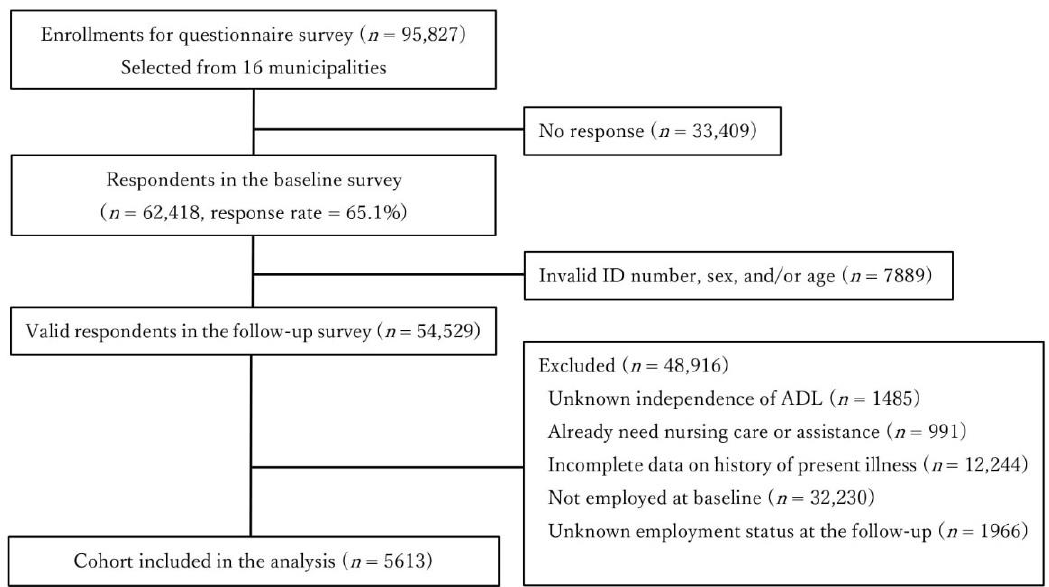
Figure 1. Participant flow diagram.